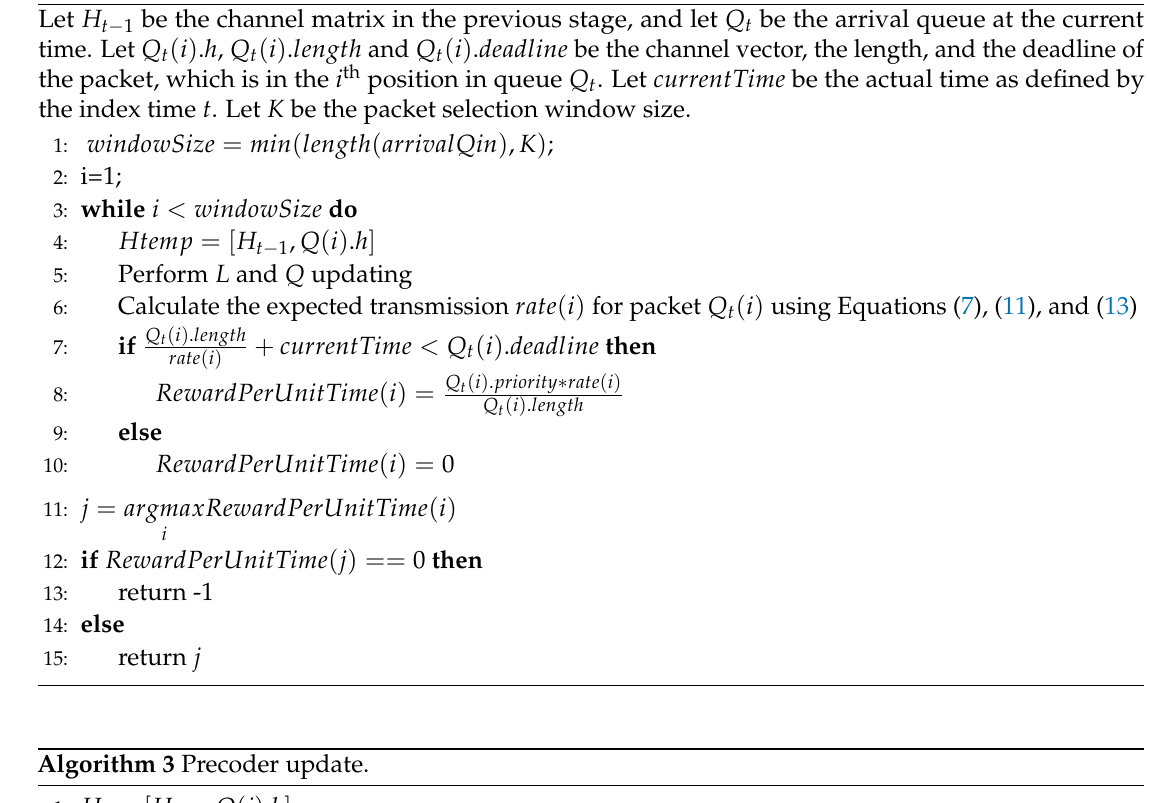
Algorithm 2 Select new packet for transmission.